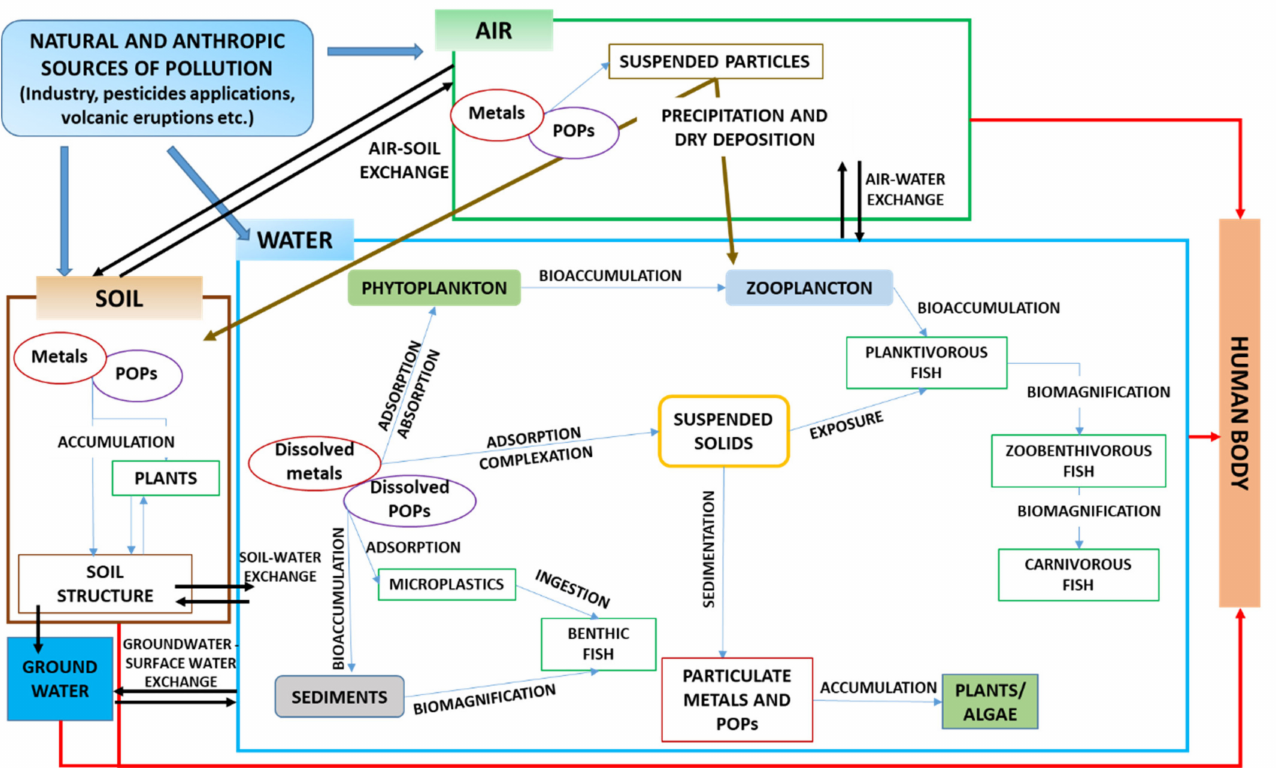
Figure 5. Transport and routes of persistent pollutants in the